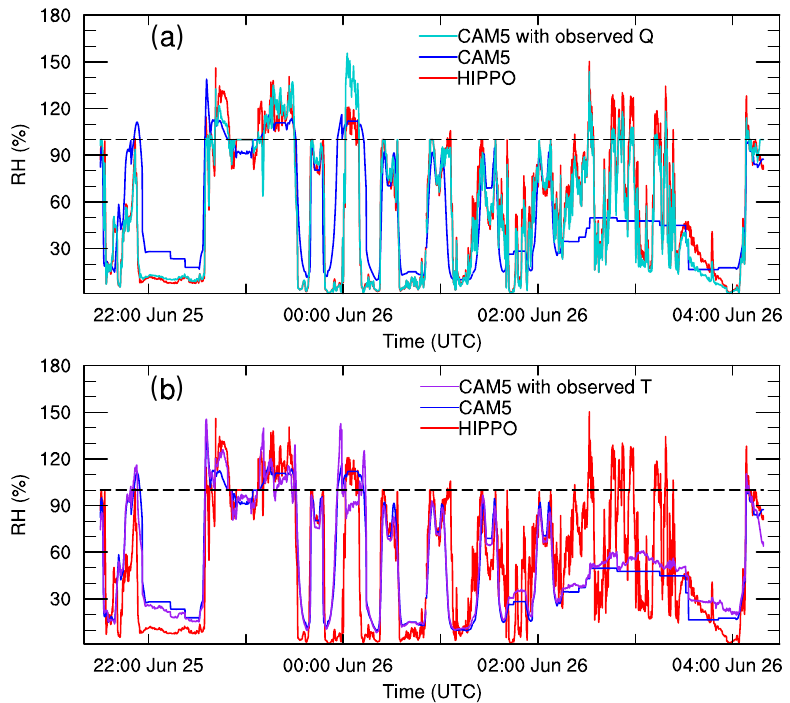
Figure 3. As Fig. 2a but for RH recalculated by replacing the model output with either (a) observed Q or (b) observed T